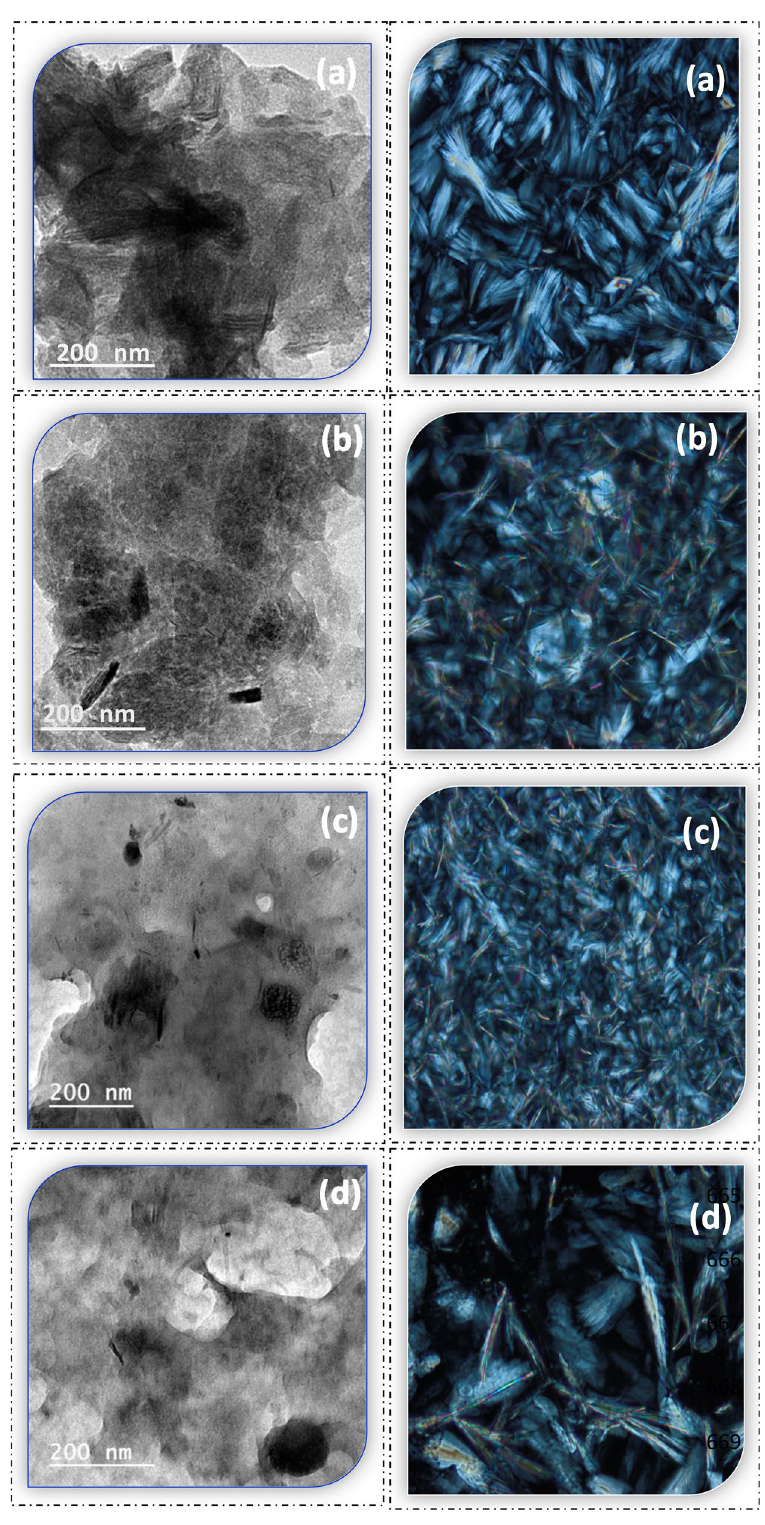
Figure 7. TEM (left) and PLM (right) micrographs of functional spreadable oleogel ( a ) spreadable O ( b ) spreadable P, ( c ) spreadable D, and ( d ) spreadable